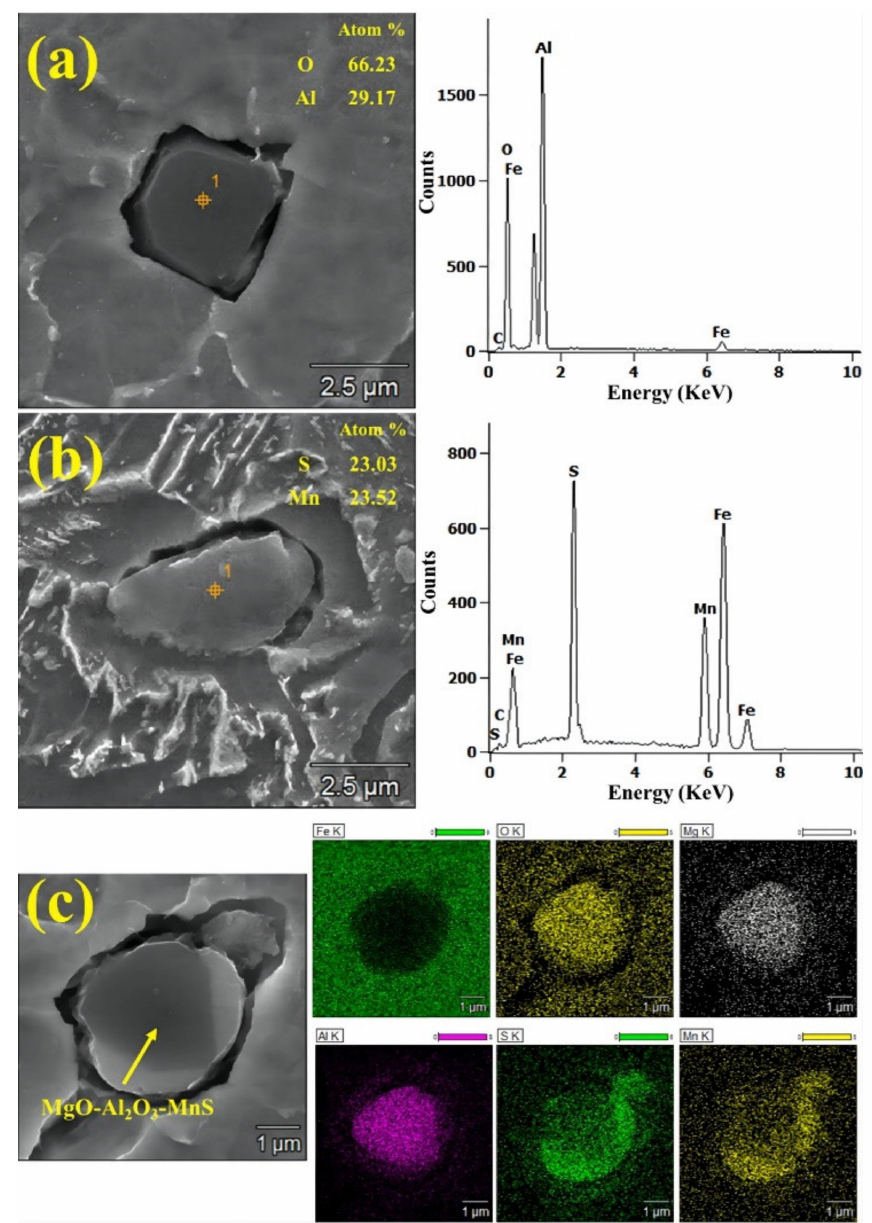
Figure 2. Morphology and type of ( a – c ) inclusions formed in 0RE